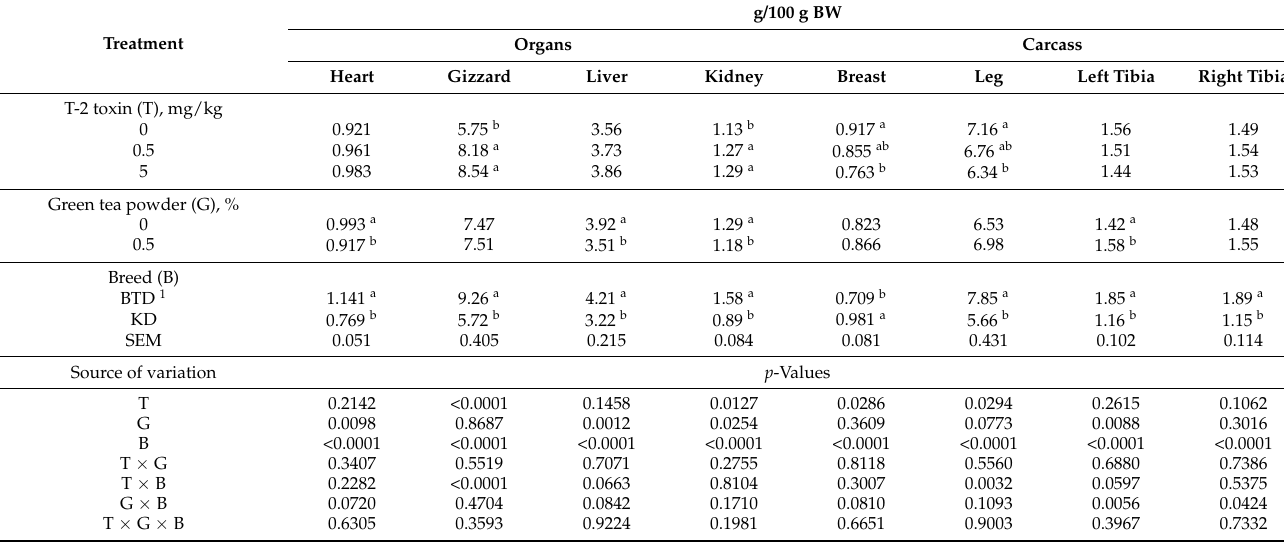
Table 5. Effects of diets containing T-2 toxin and green tea powder on the relative weights of organs and carcass of Brown Tsaiya ducklings and Kaiya ducklings. g/100 g BW Treatment Organs Carcass Heart Gizzard Liver Kidney Breast Leg Left Tibia Right Tibia T-2 toxin (T), mg/kg 0